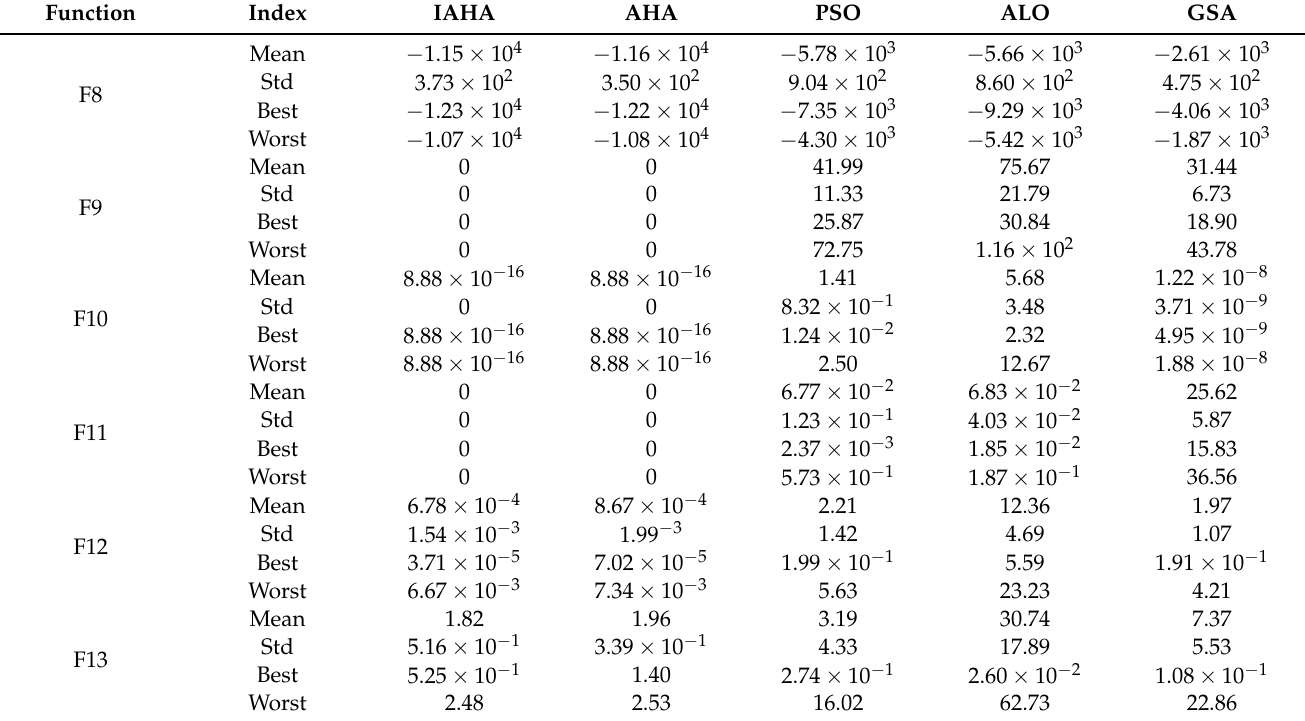
Table 3. Statistical results of high-dimensional multi-peak test functions for each